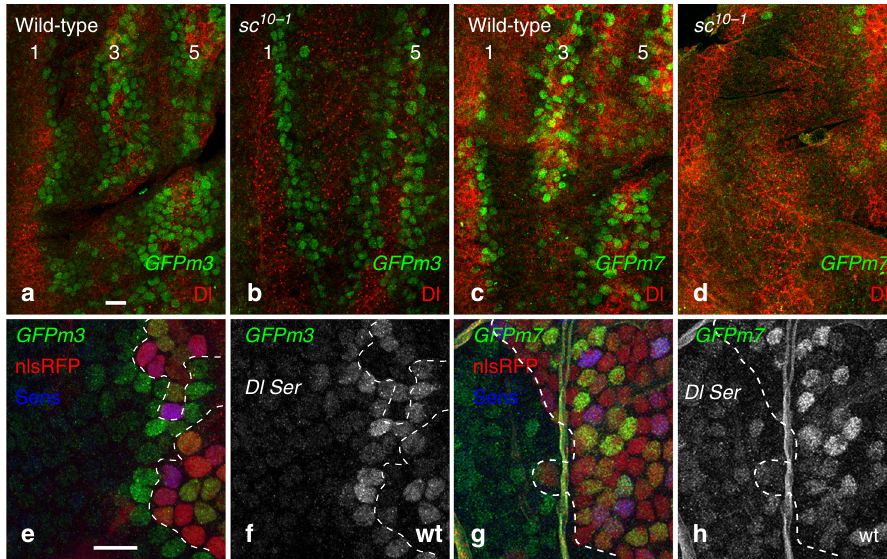
Fig. 7 Regulation of the late onset E(spl)-HLH genes by Ac and Sc. a – d Pattern of expression of the GFPm3 ( a , b ) and GFPm7 ( c , d ) reporters (GFP, green; Dl, red) in the notum of wild-type ( a , c ) and sc 10 – 1 ( b , d ) 7 – 8 h apf pupae. While the expression of GFPm3 did not depend on Ac and Sc ( a , b ), GFPm7 was not expressed in the absence of Ac and Sc ( c, d ) with the exception of a few anterior cells along stripe 5 ( d ). Note that the expression of Dl in stripe 3 did not depend on Ac and Sc 64 . e – h GFPm3 (GFP, green in e , f ) was not expressed by Dl rev10 Ser RX10 mutant cells (clone border outlined by a white dashed line; non-mutant cells express nlsRFP, red; Sens, blue) with the notable exception of the mutant receiving cells that are in direct contact with the wild-type signal sending cells ( e , f ). In contrast, expression of GFPm7 (GFP, green in g , h ) was observed in mutant cells, indicating that expression of the m7 gene did not strictly depend on ligand-dependent Notch signaling. Clone borders (dotted line) and genotypes ( Dl Ser vs. wild-type, wt) are indicated. Scale bars are 10 μ m ( a : a – d ; e : e – h